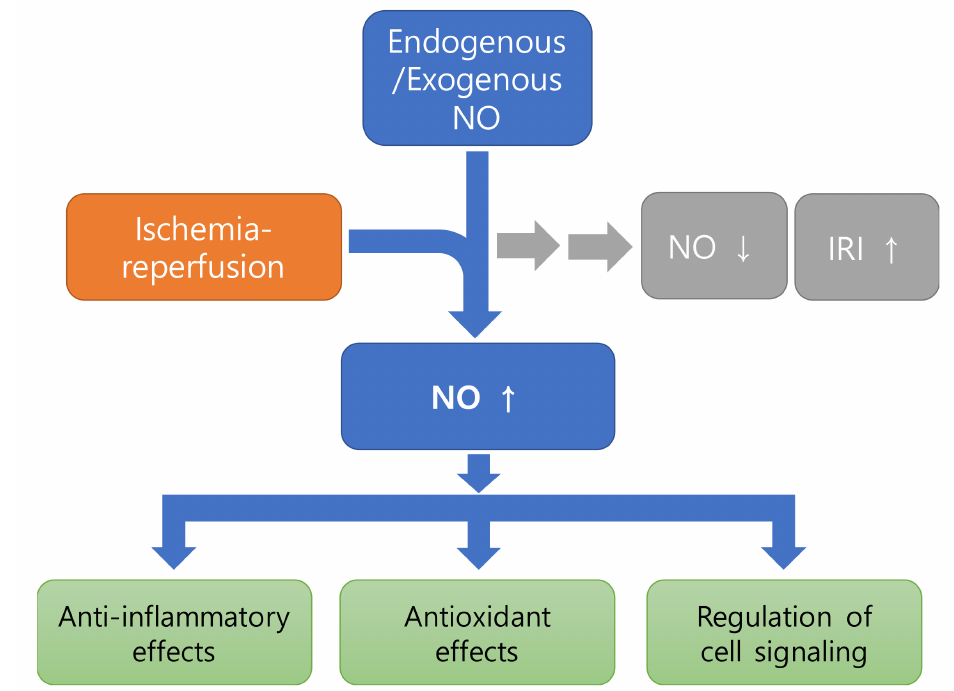
Figure 1. Diagram showing the protective effects of NO against IRI by modulating various aspects of cellular function. It can be seen that endogenous or exogenous NO restores NO reduction and inhibits further progression of